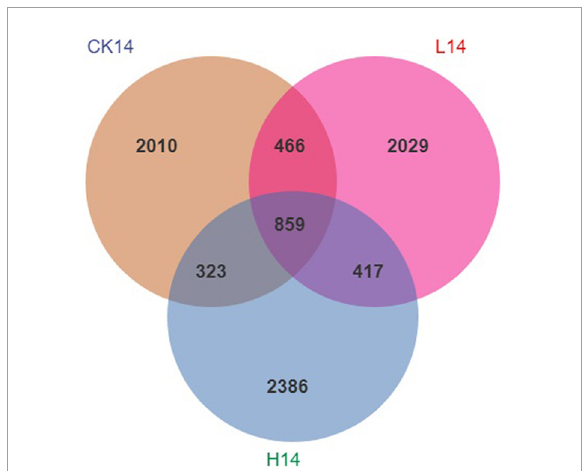
FIGURE1 Venn diagram analysis depicting the numbers of shared and unique Amplicon Sequence Variants (ASVs) among the control (CK14), 0.5 mg/L (L14), and H14 (1.5 mg/L)